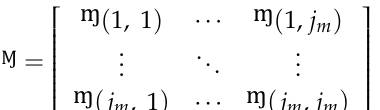
Figure 2. Illustration of the phases of the research study.